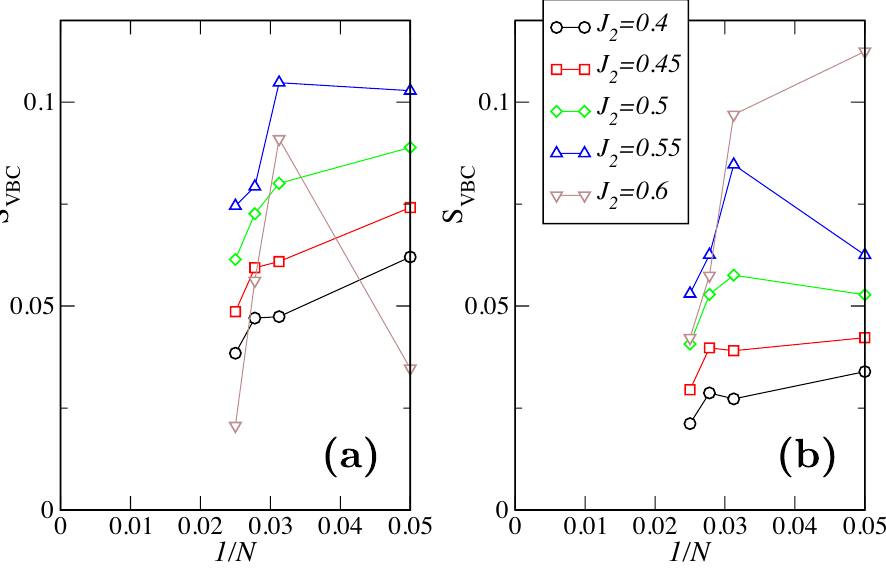
Figure 9: (a) Scaling of the VBC order parameter square S for the modified VBC order parameter S ∗